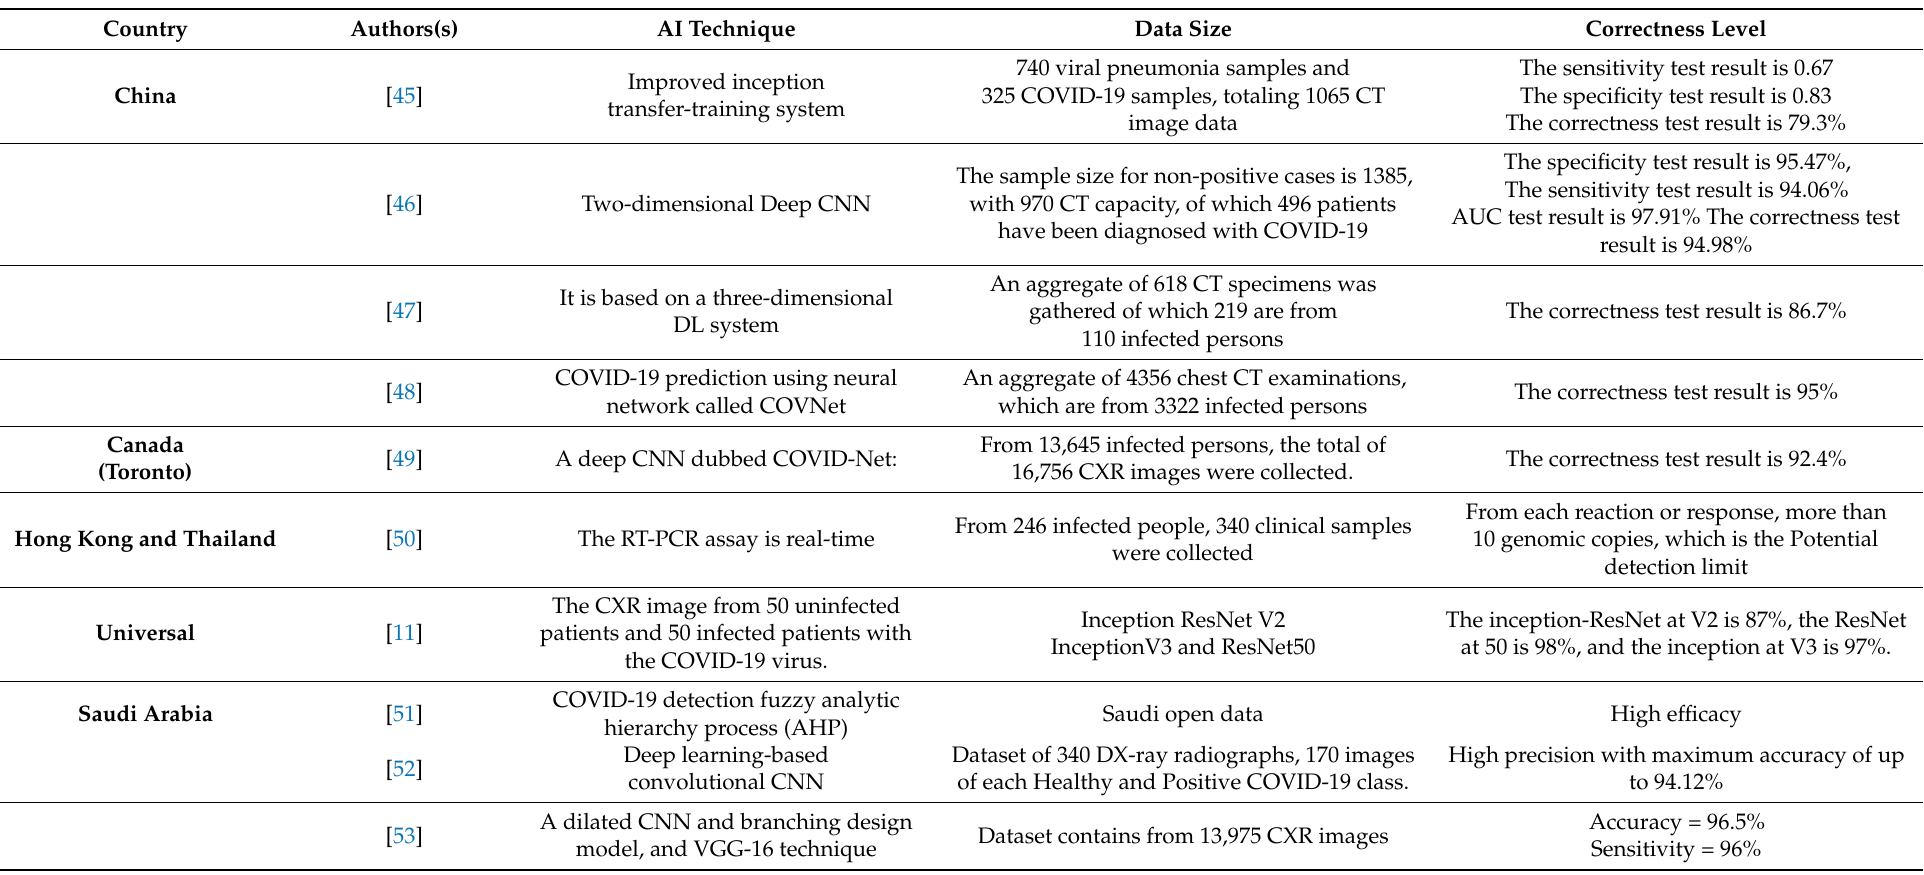
Table 1. Use cases of AI in CT diagnosis for COVID-19